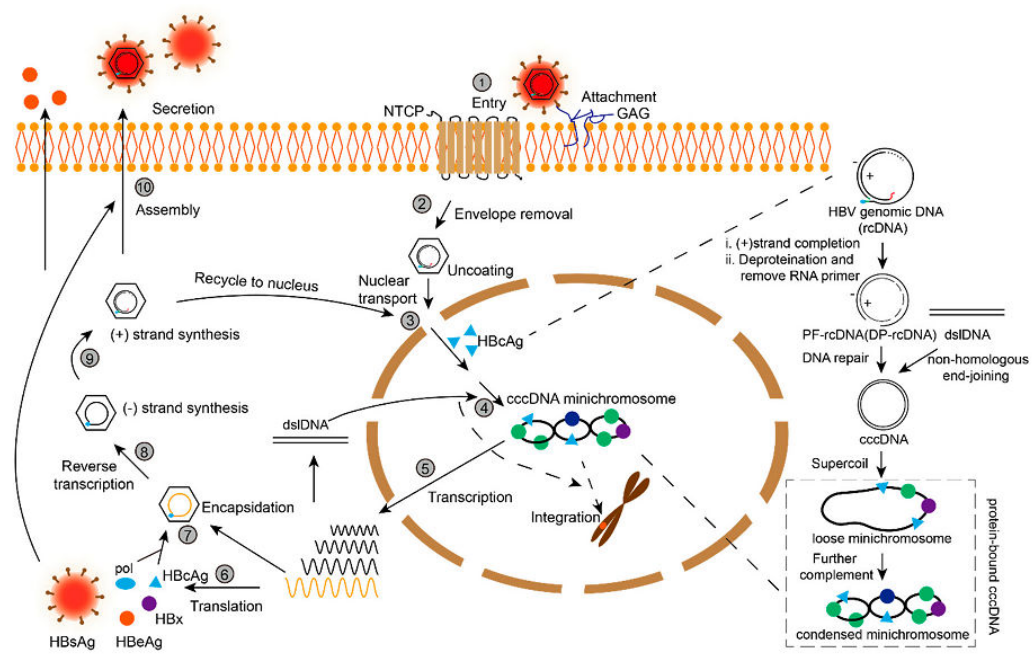
Figure 1. Formation of covalently closed circular DNA (cccDNA) in the hepatitis B virus (HBV) life cycle. ① Attachment and entry of HBV via glycosaminoglycan (GAG) and sodium taurocholate cotransporting polypeptide (NTCP); ② Removal of the envelope and the inner nucleocapsid is released into the cytoplasm; ③ Transport of nucleocapsid into the nucleus pore and release of the polymerase (pol)-linked relaxed circular DNA (rcDNA); ④ Conversion of cccDNA from rcDNA and double-stranded linear DNA (dslDNA). rcDNA is the main source of cccDNA; the incoming or intracellular amplified rcDNA fills in the gap in plus strand and removes the pol and RNA primer from the 5 ′ -terminus of minus and plus strand to form the protein-free (PF)-rcDNA, which is also called deproteinized-rcDNA (DP-rcDNA). The end of both strands of PF-rcDNA is further ligated to form cccDNA. In addition, a fraction of cccDNA is synthesized from dslDNA by non-homologous end-joining (NHEJ). The episomal cccDNA once formed is assembled into minichromosomes including loose or spread and condensed forms bound to histone and non-histone proteins; ⑤ Transcription of viral mRNAs (3.5 kb pregenomic RNA (pgRNA) and precoreRNA, 2.4 kb and 2.1 kb preS/S mRNAs and 0.7 kb X mRNA ) from cccDNA minichromosomes; ⑥ Translation of HBV proteins: hepatitis B surface antigen (HBsAg), hepatitis B e antigen (HBeAg), hepatitis B core antigen (HBcAg), HBV X protein (HBx) and polymerase (pol); ⑦ Encapsidation involving pgRNA, pol and HBcAg; ⑧ Synthesis of HBV minus strand via reverse transcription of pgRNA; ⑨ HBV plus strand synthesis; ⑩ Assembly of capsid containing rcDNA with HBsAg to form virion which secrets out of the cell. Dashed line: Variable 3 ′ -end of the plus-strand; Red line: RNA primer at the 5 ′ -end of the plus-strand; Green line: Redundant sequences at 5 ′ - and 3 ′ -end of the minus-strand; Blue oval: Polymerase.